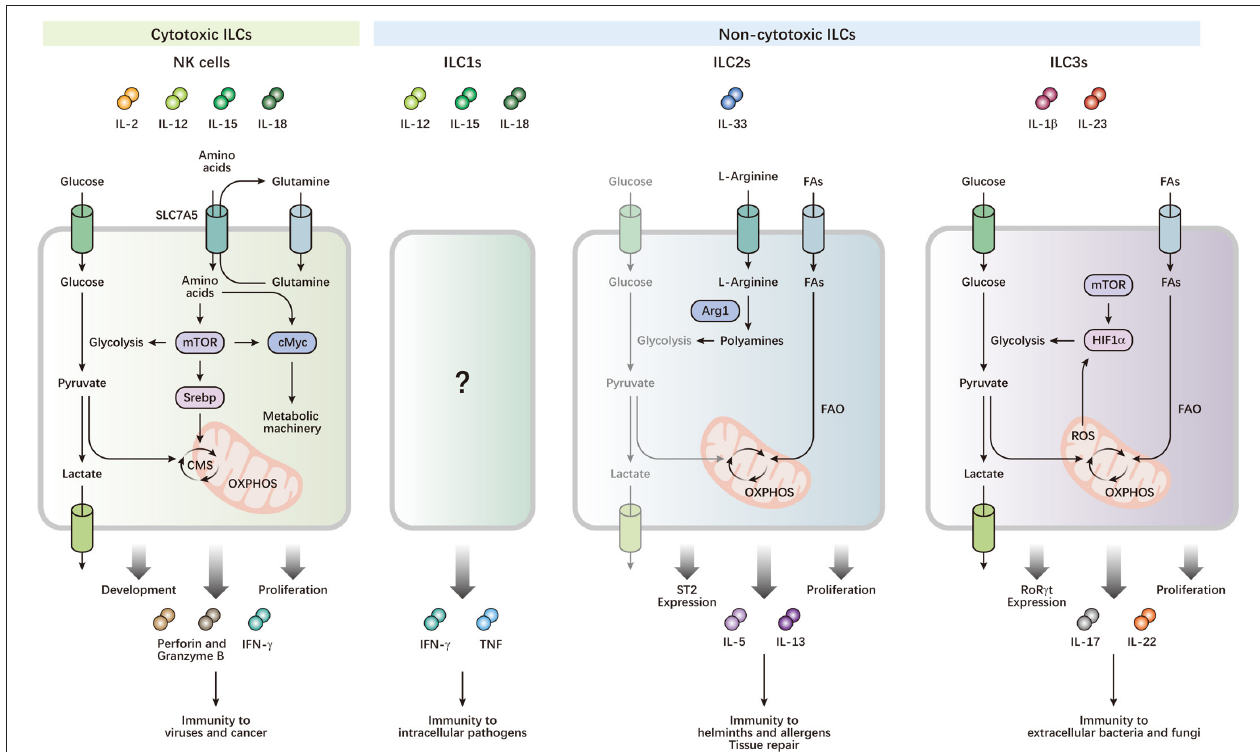
FIGURE 1 | Metabolism drives the development and functions of ILCs. ILCs can be activated by cytokine signals from local microenvironments, and contribute to immune defense and maintenance of homeostasis. NK cells preferentially utilize glucose, which is metabolized by glycolysis and CMS, to fuel OXPHOS and ATP production, which power their effector functions and rapid proliferation. cMyc and Srebp are important metabolic regulators, which control the expression of metabolic machinery and CMS, respectively. mTOR activity is required for optimal Srebp activity and the initial induction of cMyc, while maintenance of cMyc protein levels depends on SLC7A5, which transports glutamine out of the cell, facilitating transport of other amino acids into the cell. Leucine imported by SLC7A5 improves mTOR activity. High mTOR activity is also critical for increased metabolism to support proliferative expansion during NK cell development. ILC2s preferentially generate energy by breaking down FAs, but not glucose, for OXPHOS to respond to helminths and allergens. Arg1 is required for ILC2 cytokine production and optimal proliferation through the conversion of L-arginine into polyamines. Arg1 also promotes ILC2 glycolytic capacity. The balance of metabolism between FAO and glycolysis is important for expression of the IL-33 receptor ST2, and production of IL-5 and IL-13 in ILC2s. Activated ILC3s exhibit increases in both glucose and FA metabolism. Rapid proliferation and effector functions of ILC3s require mTOR-HIF1 α -dependent glycolysis and ROR γ t expression. Mitochondrial respiration and production of mitochondrial ROS stabilizes HIF1 α , thereby consolidating ILC3